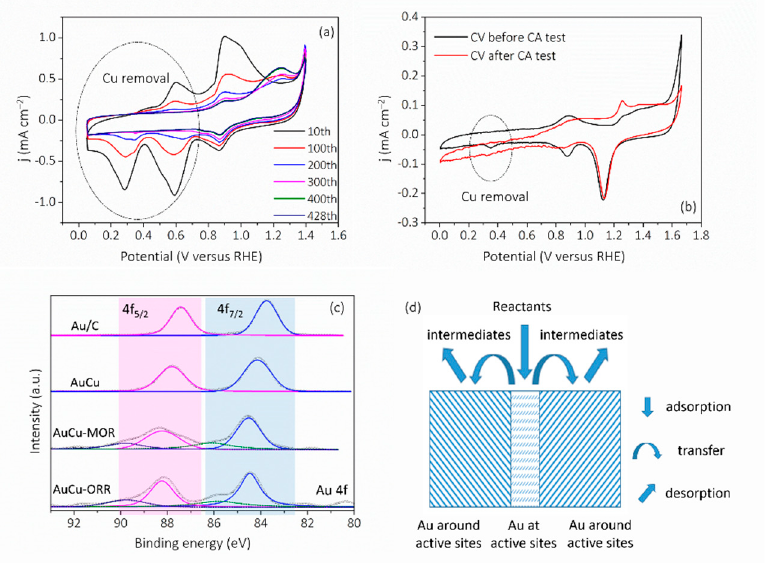
Figure 8. ( a ) CV curves of AuCu taken at various circles of MOR. ( b ) CVs of AuCu taken before and after ORR-CA. ( c ) High-resolution Au 4f XPS spectra. ( d ) Schematic diagram of reaction mechanism.